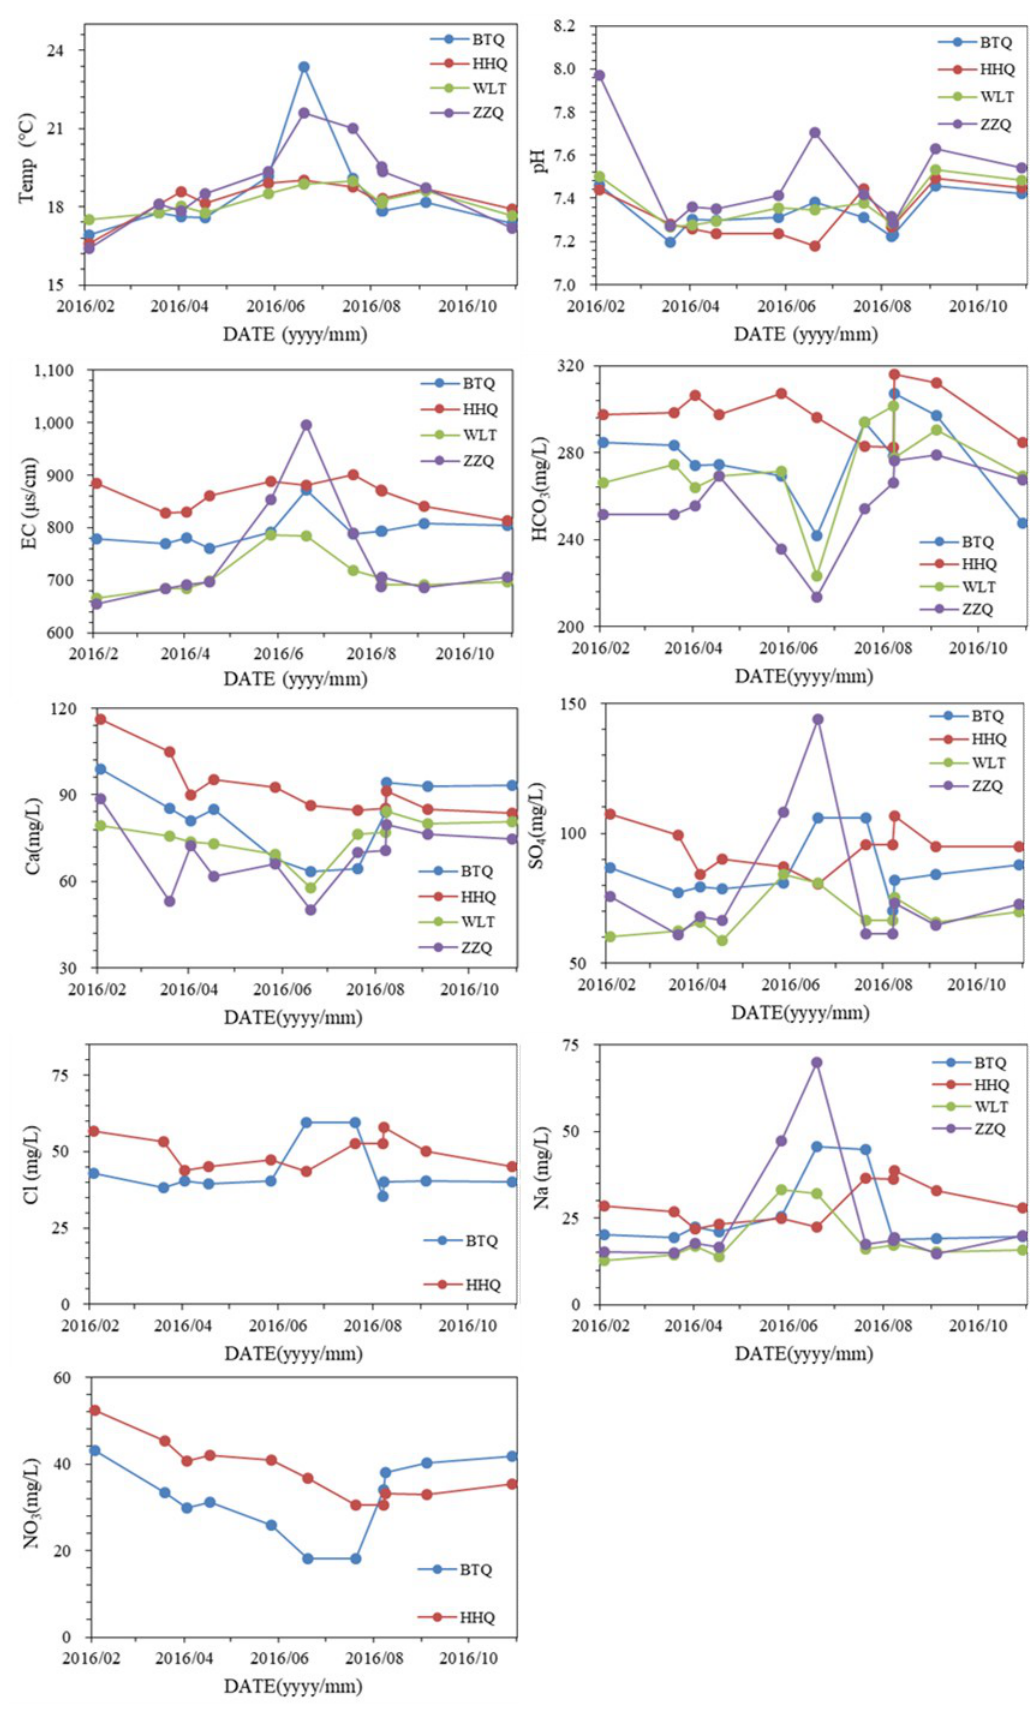
Figure 4. The temporal series of physical and chemical parameters in karst springs.